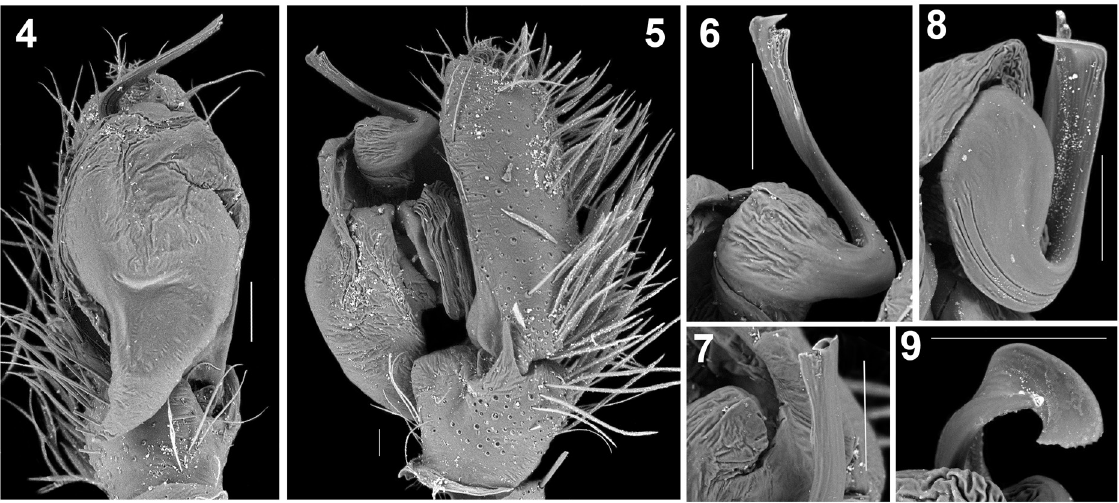
Figs 4–9. Scanning electron micrographs of Rafalus christophori Prószyński, 1999 (4–7) and Aelurillus v-insignitus (Clerck, 1757) (8–9). 4–5 . Male palp. 4 . Ventral view. 5 . Retrolateral view. 6–9 . Embolic division. 6, 8 . Retrolateral view. 7, 9 . Apical view. Scale bars: 0.1